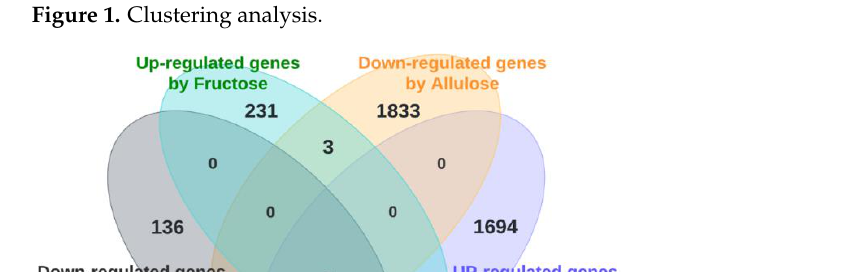
Figure 1. Clustering analysis.